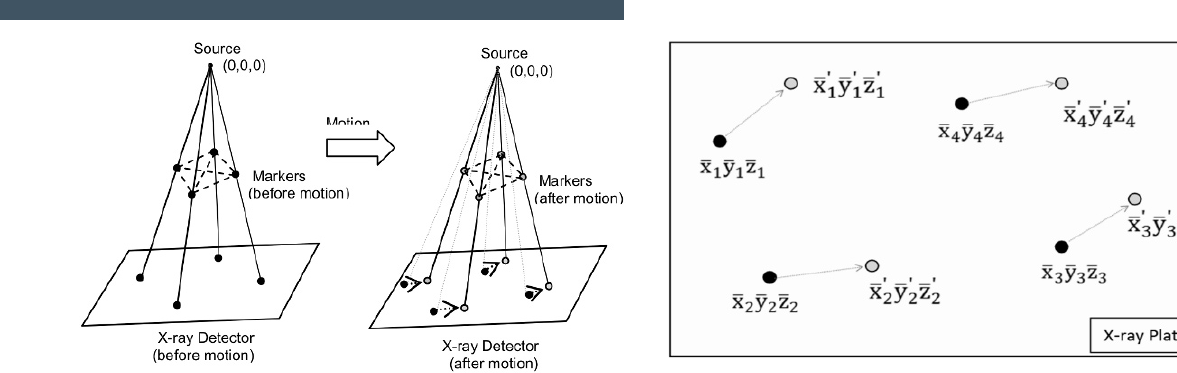
drawing a line, which is parallel to the line between the projections (¯ x 1 ¯ y 1 ¯ z 1 ) and ¯ x sition to the shifted line. The intersection point, ¯ x is the approximate position of the shifted marker1.